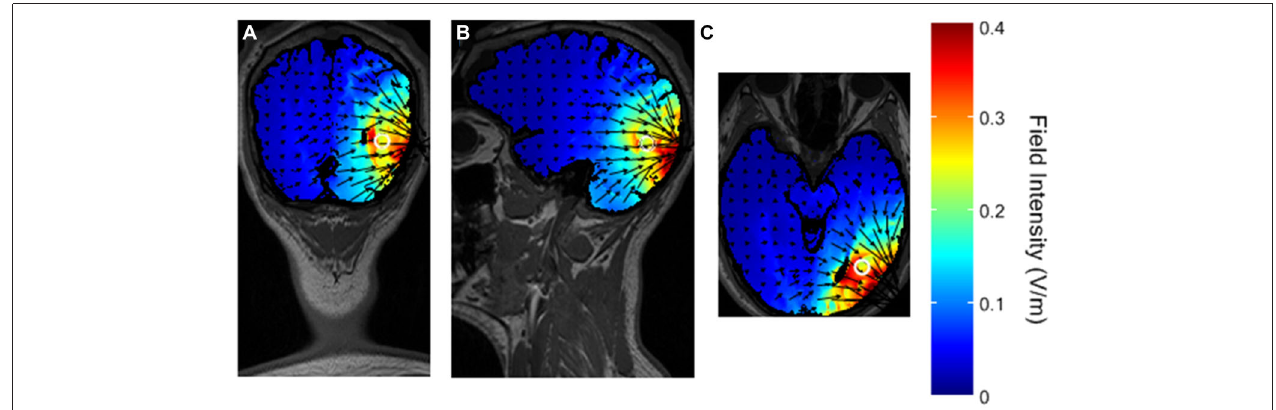
FIGURE 4 | Simulated distribution of the electrical field in the brain with the selected montage. The white circle represents the presumed V5 in the head model. (A) coronal view. (B) sagittal view. (C) axial view.